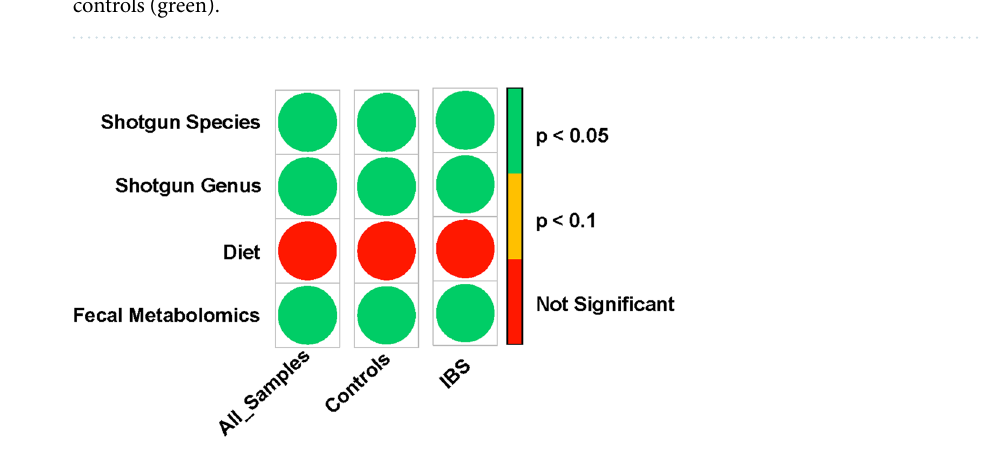
Figure 4. Co-inertia analysis between mycobiome composition with bacterial composition (All subjects: n = 138, controls: n = 58, IBS: n = 80), food consumption (All subjects; n = 144, controls: n = 64, IBS: n = 80), and fecal metabolome (All subjects; n = 142, controls: n = 62, IBS: n = 80). Mycobiome showed significant association with bacterial composition and fecal metabolome but failed to show significance with food consumption. Degree of association as RV coefficient is presented in supplementary Table